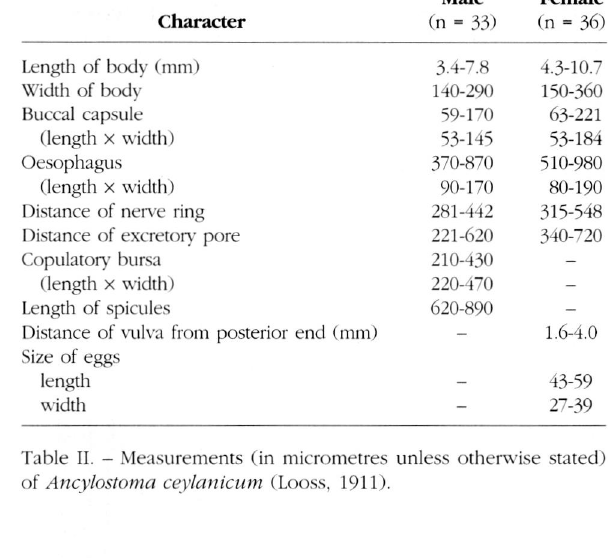
Table II. - Measurements (in micrometres unless otherwise stated) of Ancylostoma ceylanicum (Looss,